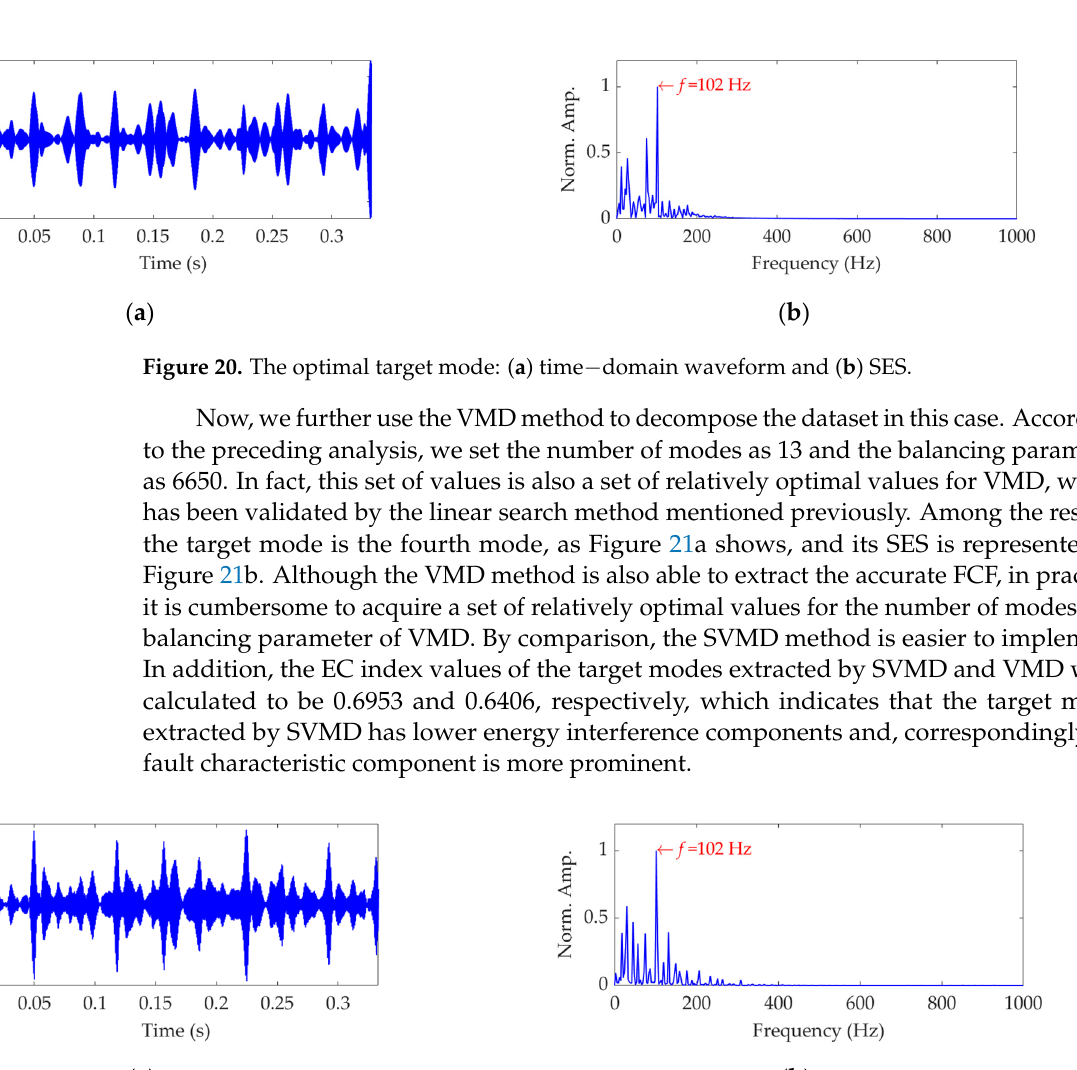
( b ) Figure 18. Relationship between the α value and ( a ) the EP index value and ( b ) order number of the target mode at each step of α increase.